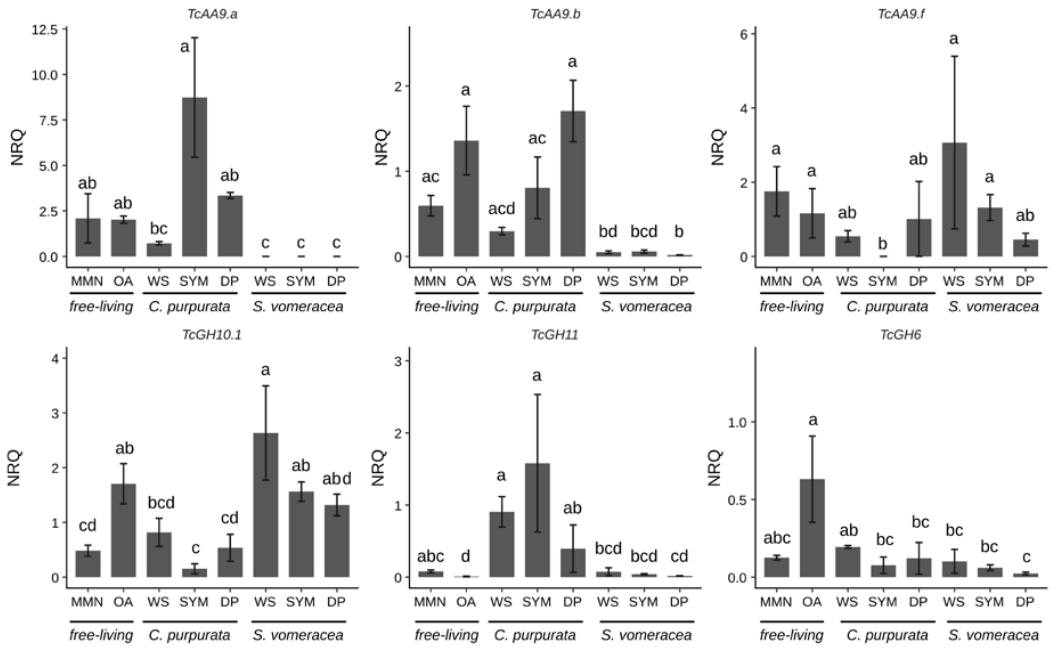
Figure 4. CAZymes expression under different experimental conditions. Letters indicate significant differences after Kruskal-Wallis test and Dunn’s post-hoc test ( p < 0.05). NRQ, normalized relative quantities; mean ± standard error (SE) is plotted.